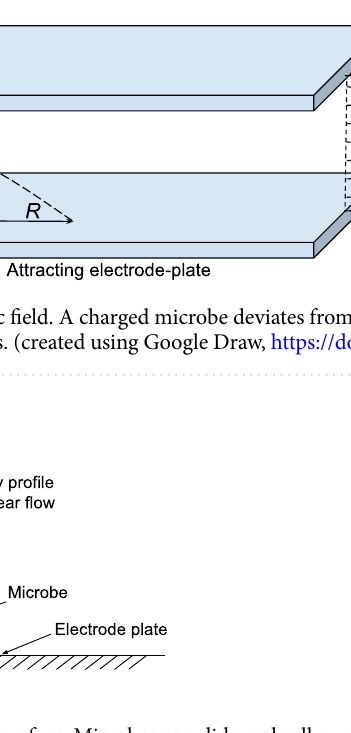
Figure 2. Microbe slippage on solid surface. Microbes can slide and roll over a flat surface due to hydrodynamic force and torque exerted by the flow. (created using Google Draw, https:// docs. google.